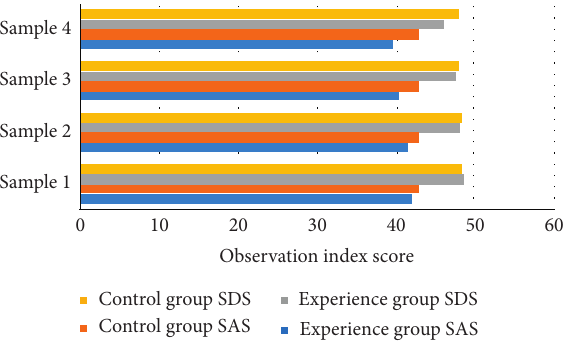
Figure 4: Score of anxiety and depression of football